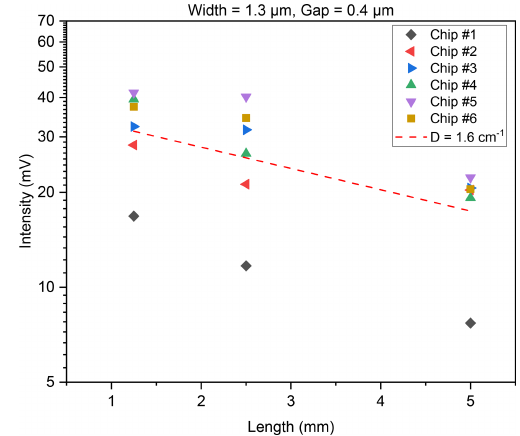
Figure 4. Determination of waveguide damping. The measured intensity of transmitted light through multi-strip waveguides of three different lengths ( L = 1 . 25, 2.5, and 5mm) is plotted on a logarithmic scale. The damping is determined by an lin- ear fit (red dashed line). For the described waveguide geome- try (width = 1.3µm/gap = 0.4µm), a damping value of D exp = 1 . 6cm − 1 is